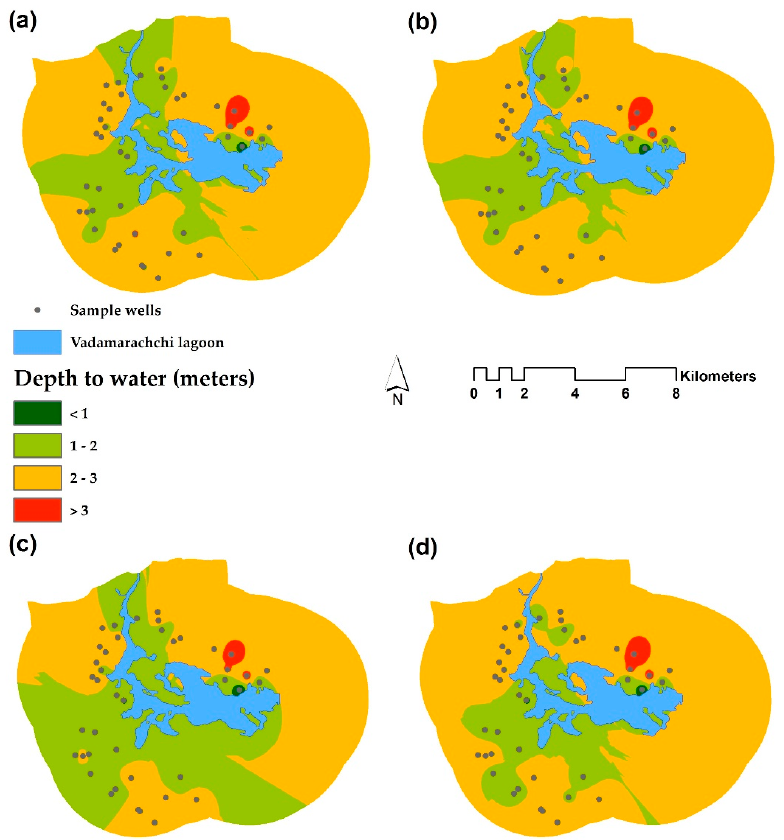
Figure 5. Variation of depth to water: ( a ) March, ( b ) April, ( c ) May, and ( d ) June during the dry